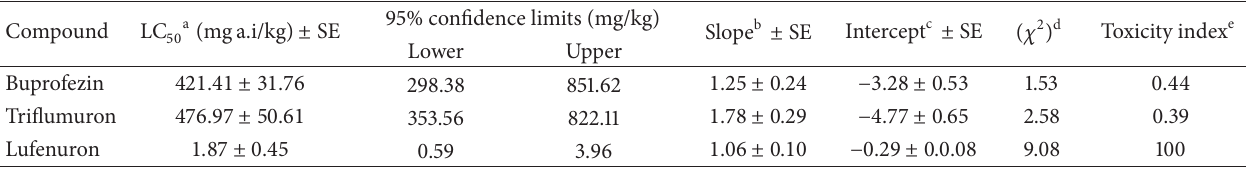
Table 2: Toxicity of buprofezin, triflumuron, and lufenuron on mature earthworms ( A. caliginosa ) 28 days after treatment.